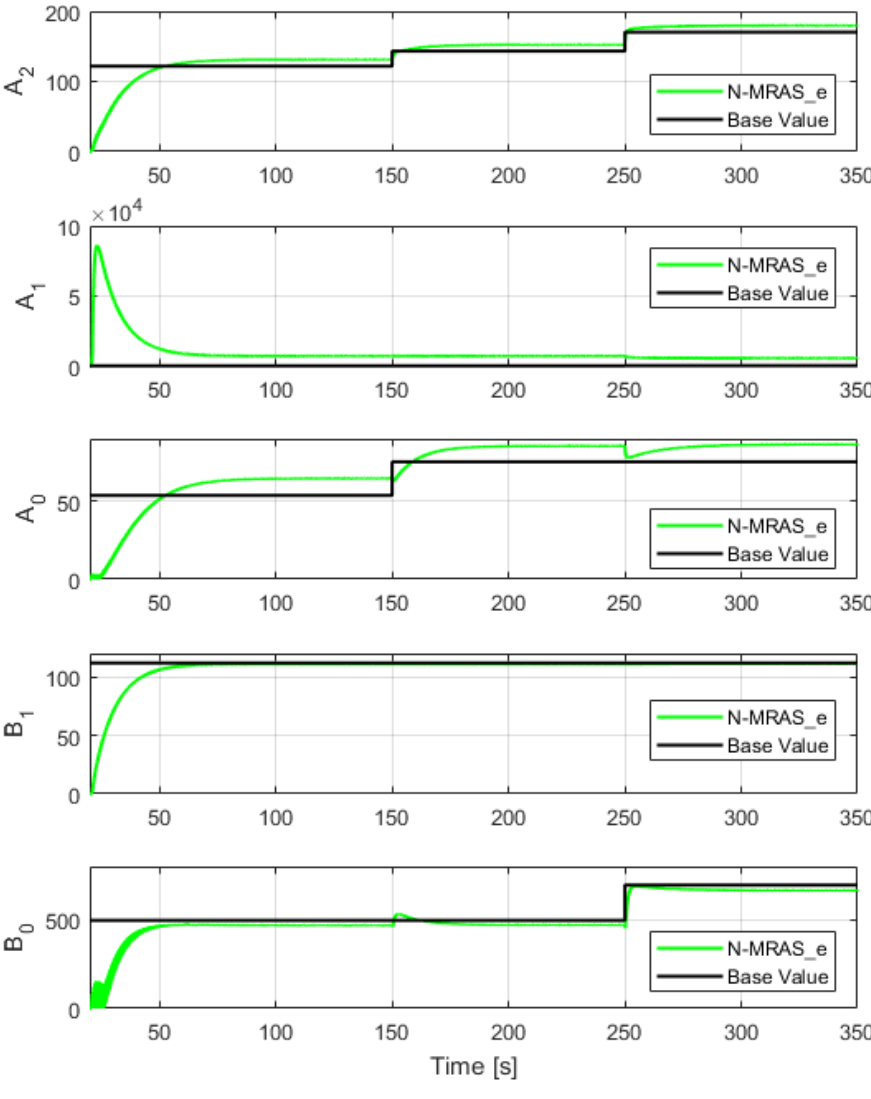
Figure 10. N-MRAS_e response in front of Step 1 and Step 2 at 150 s and 250 s,